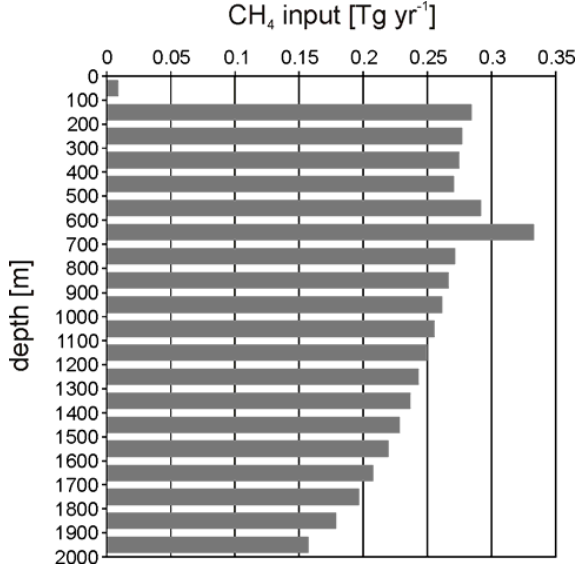
Figure 2 Fig. 2. Methane inputs into different water depths based on steady state Model